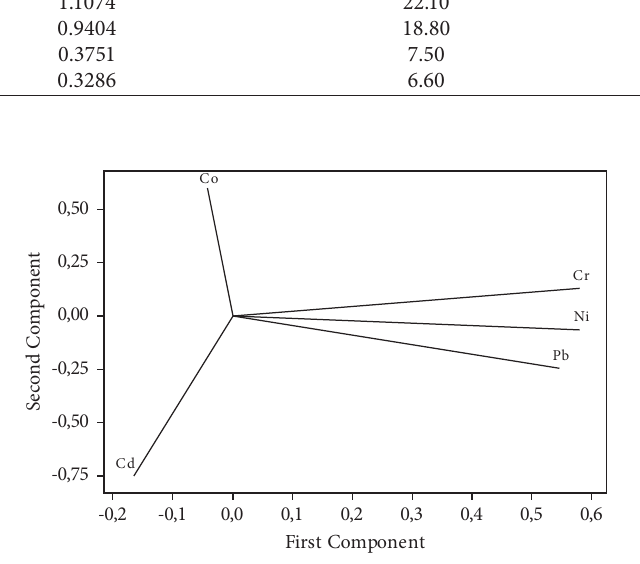
Figure 3: The loading plot of Pb, Cd, Co, Cr, and Ni from two components (PC1 and PC2). Table 4: Principal component (PC) matrix correlating heavy metal concentrations in shallot fields in Brebes Regency, Central Java,